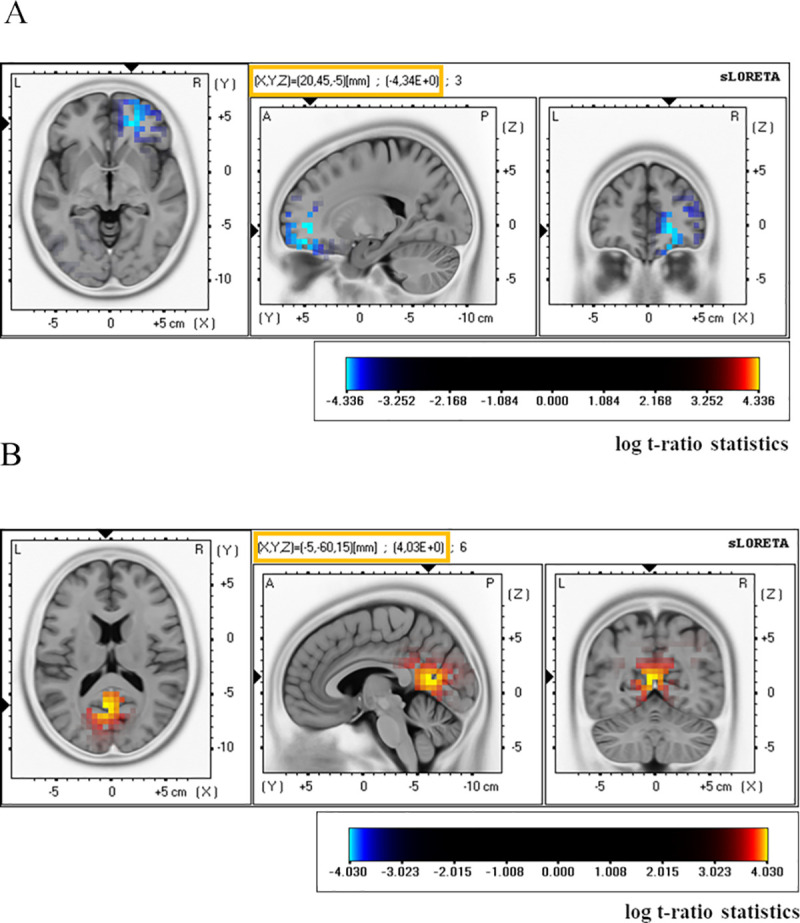
Significant results for current density amplitude analysis in the low alpha (8–10 Hz) band (A) and middle beta (15–18 Hz) band (B). In the high distress tinnitus patients sLORETA current source density in the low alpha band was lower in the tinnitus focus condition compared to the body focus condition in the right frontal/cingulate cortex and, in the same contrast, the current density in the middle beta (15–18 Hz) was higher in the posterior cingulate/precuneus area. T-statistic that are positive are displayed in red (the mean current density in the body focus condition is greater than the mean in the tinnitus focus condition) and those that are negative in blue (the mean current density in the body focus condition is lower than the mean in the tinnitus focus condition). The horizontal (left) sagittal (middle), and coronal (right) sections through the voxel with maximal t-statistic are presented. The maximal t-value and MNI coordinates of the voxel with this value are shown in the yellow frame above a sagittal section. The image shows significant outcomes only.